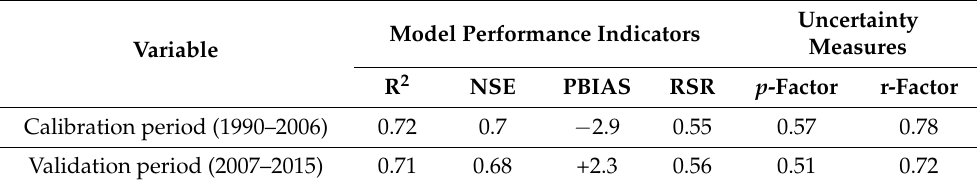
Table 6. The statistical properties index value for monthly streamflow calibration and validation processes and model uncertainty